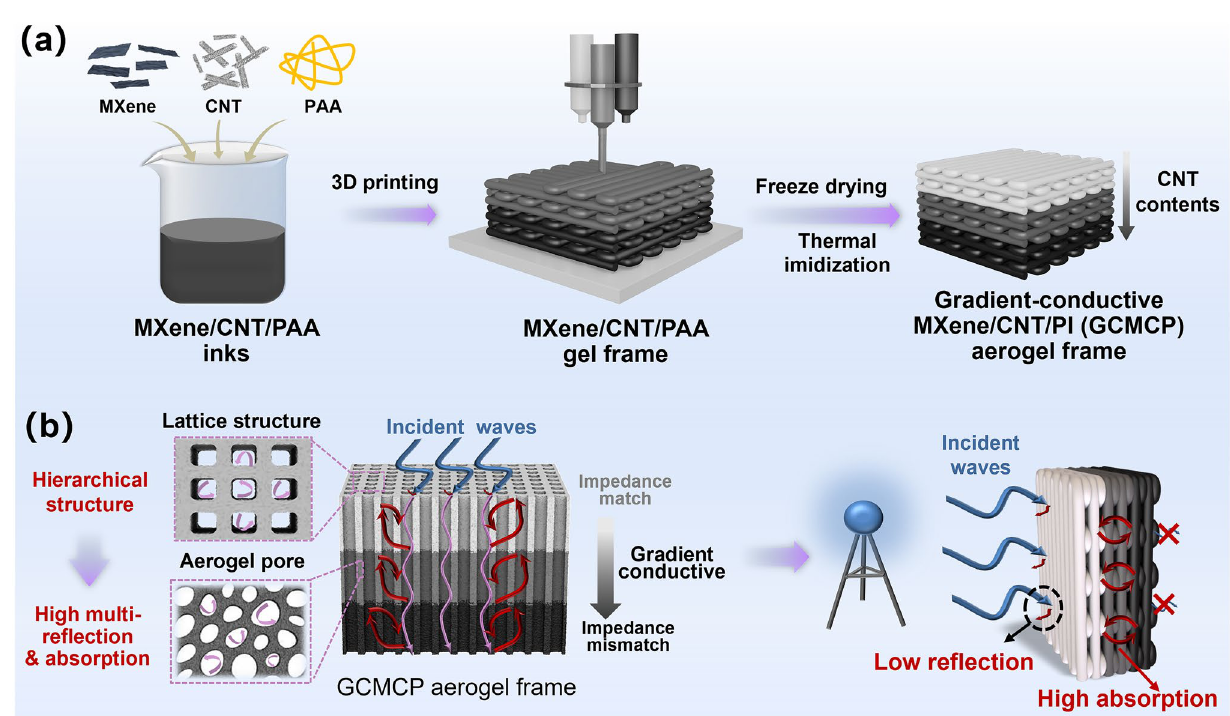
Fig. 1 ( a ) Schematic illustration of the fabrication process of the GCMCP aerogel frame. ( b ) Schematic diagram of EMI shielding mechanism of GCMCP aerogel frame and its application in the EMI shielding to reduce electromagnetic radiation